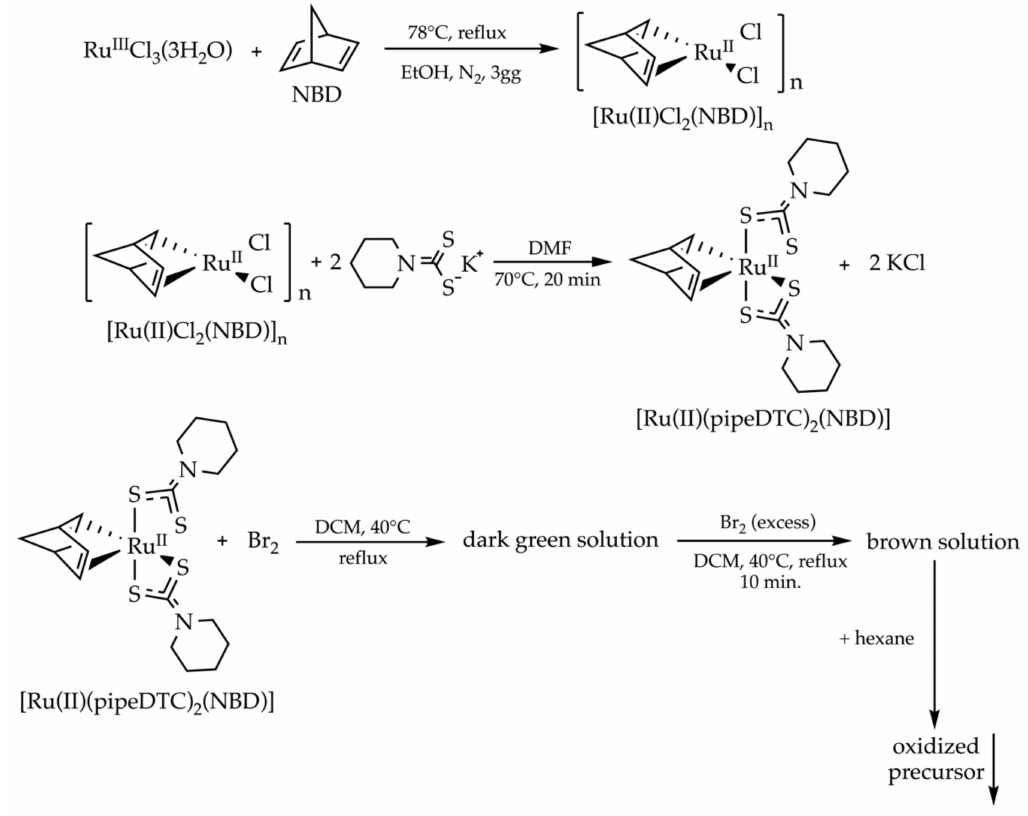
Figure 2. Reaction scheme for the synthesis of the bimetallic oxidized